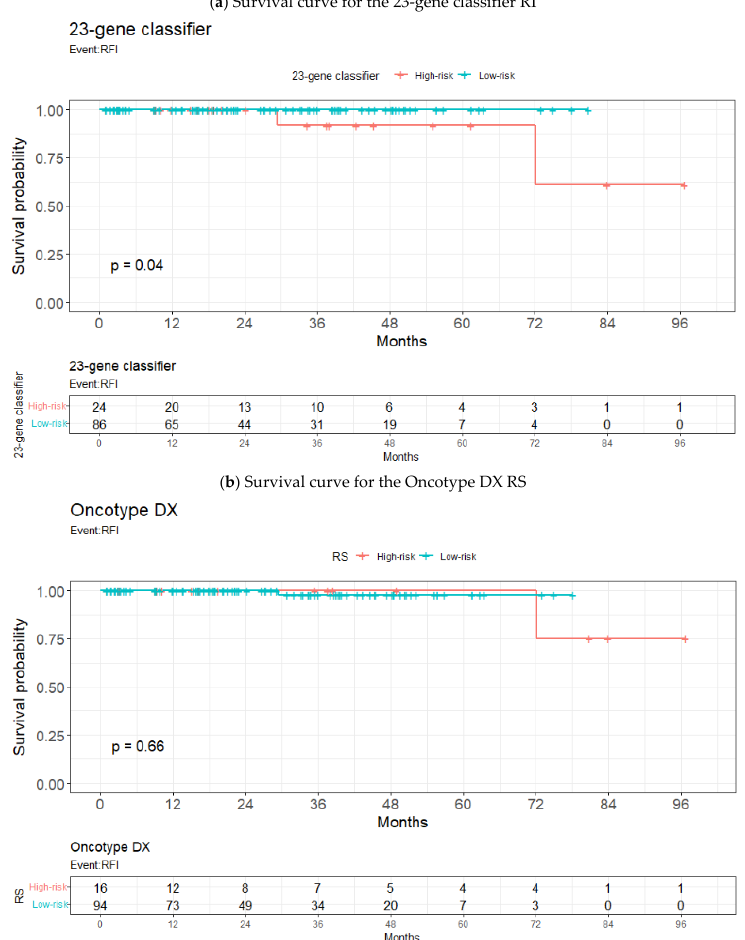
Figure 3. Kaplan–Meier plot for high-risk and low-risk/non-high-risk patients based on ( a ) the 23- gene classifier RI and ( b ) Oncotype DX ® RS. 23-gene classifier RI and ( b ) Oncotype DX ®